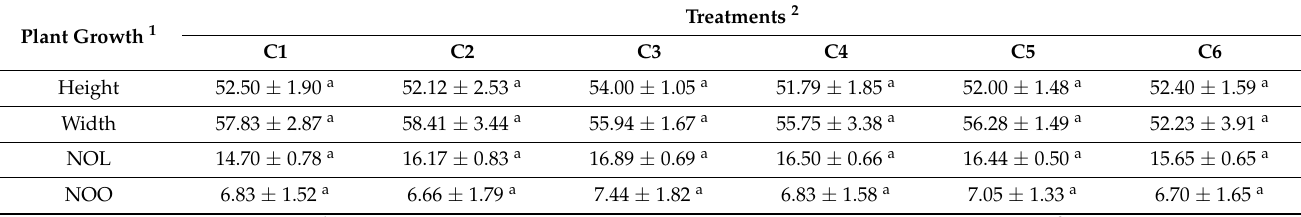
Table 3. The effects of fertilizer and microbial inoculants on Aloe vera